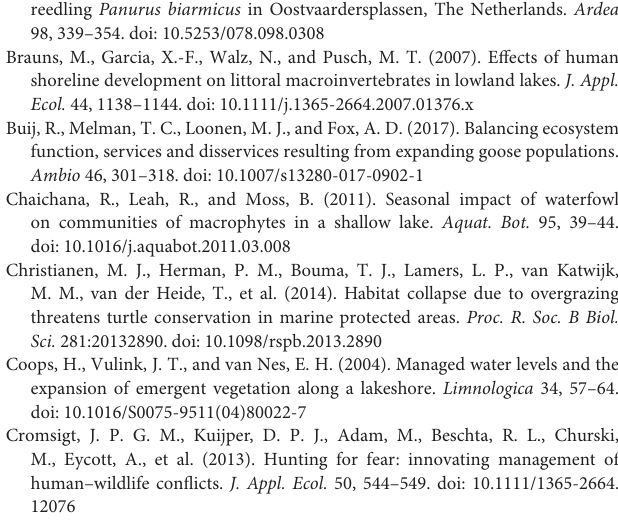
Supplementary Figure 1 | Design and development of the reed planting experiment at Lake Terra Nova. (A) Wooden bank protection to create a sheltered habitat for reed development. (B) Freshly planted reed plants. (C) Exclosure at the start of the experiment, planted reed is visible inside and outside (on the right side of) the exclosure. (D) After one year, the planted reed grew very tall inside the exclosures, whereas also other helophytes grew well inside the exclosures. Pictures by the authors. Supplementary Figure 2 | (A) Characteristic reed belt growing at the fringe of the shore of Lake Waterleidingplas. Part of it grows on the shore and part of it extends into the water, up to about 2m from the shore. The bright green patch of reed is growing in one of the exclosures in the first year on 28 June 2006. Several more exclosures are recognizable in the background, to the right of the first exclosure, with the green patches of reed. The exclosures extend 6m into the open water. (B) Reed stems and leaves grazed by Greylag geese. Both the leaves and the living stems, the green stem on the right of the picture, and the shorter greenish bitten off stem to the left of it both show the irregular fringe left at leaf and stem after goose grazing. The shorter grayish stem immediately to the left of the green stem with leaves is a stem from last year and